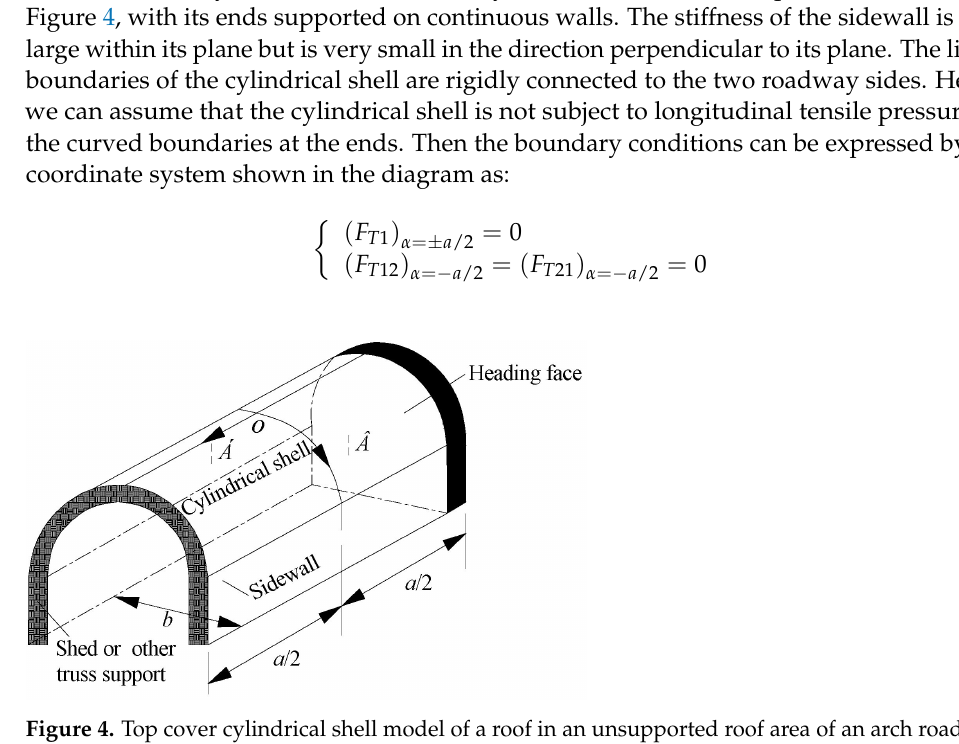
Figure 4. Top cover cylindrical shell model of a roof in an unsupported roof area of an arch